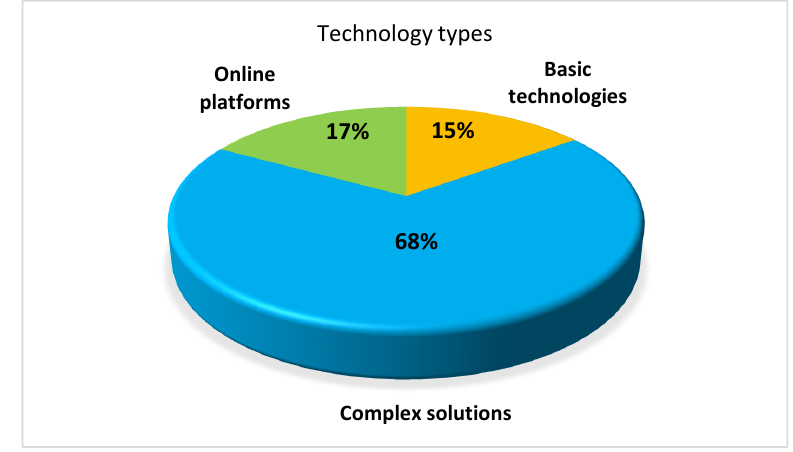
Figure 2. Proportions between solutions of different types according to their level of complexity.